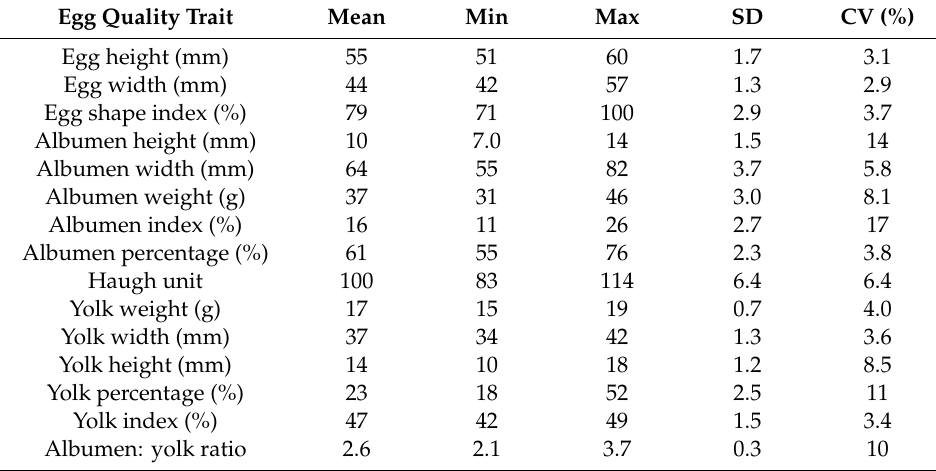
Table 4. Descriptive statistics of egg quality indices of 44 individually caged ISA Brown hens aged between 25 and 30 weeks old ( n =